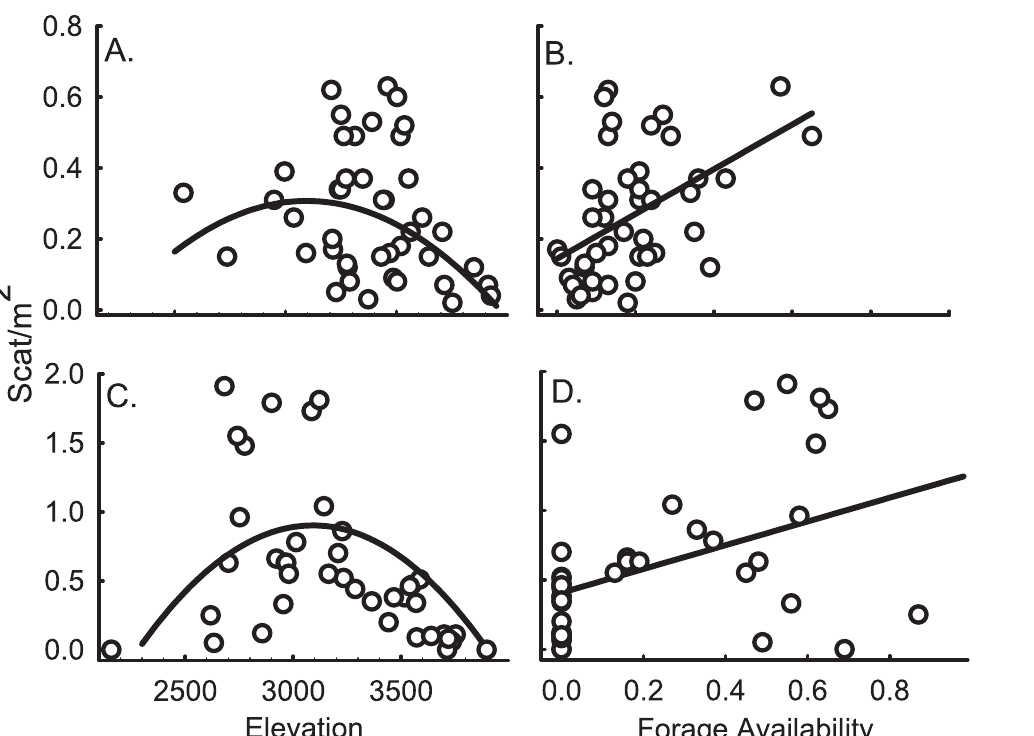
Fig 1. American pika scat density as a function of top habitat predictor variables. Scat/m 2 as a function of elevation (a) and patch forage availability (b) in the Wind River Range, Wyoming, USA, 2010 (adj. r 2 = 0.32), and elevation (c) and perimeter forage availability (d) in the Bighorn Range in 2011 (adj. r 2 = 0.40). Lines in each panel represent the predicted relationship of the top model for each range, holding patch forage (a), perimeter forage (c), and elevation (b, d) at their mean